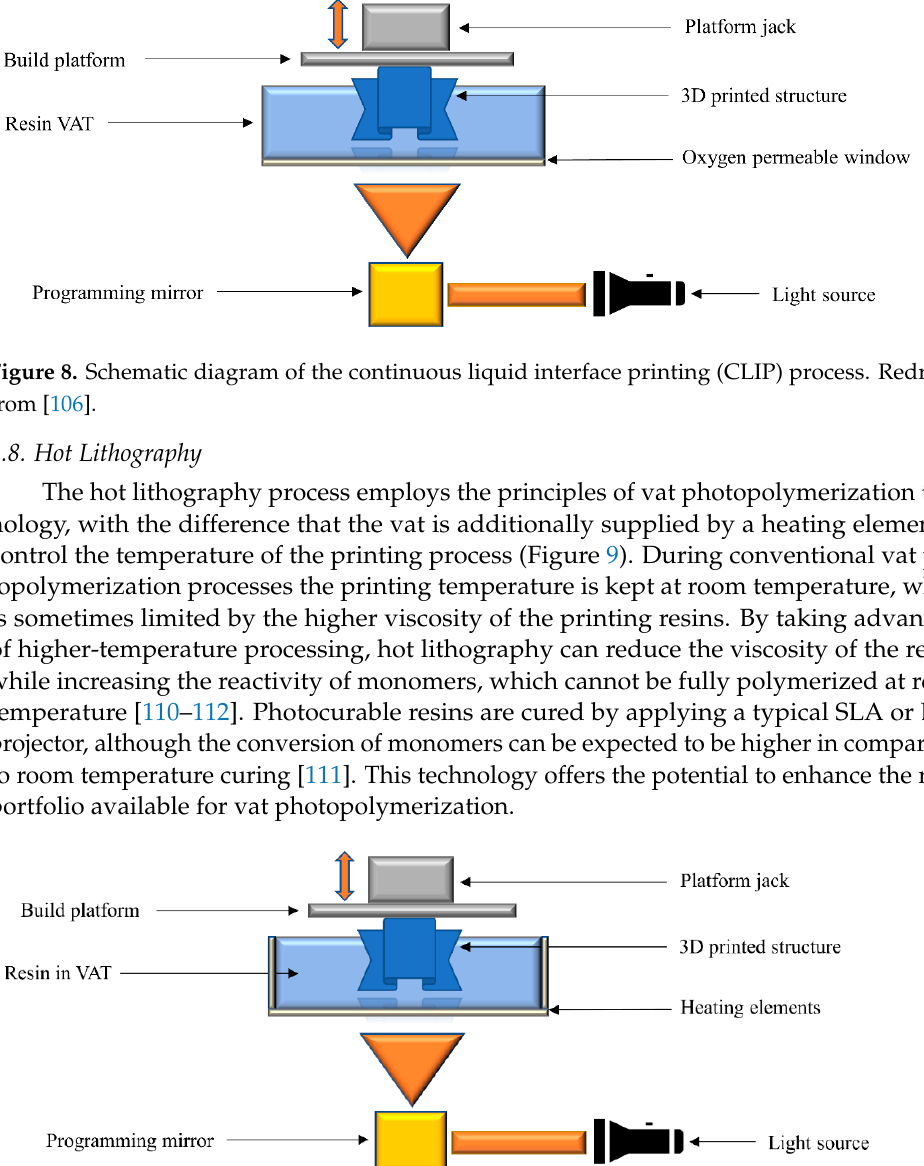
Figure 7. Schematic diagram of the liquid crystal display (LCD) printing process.